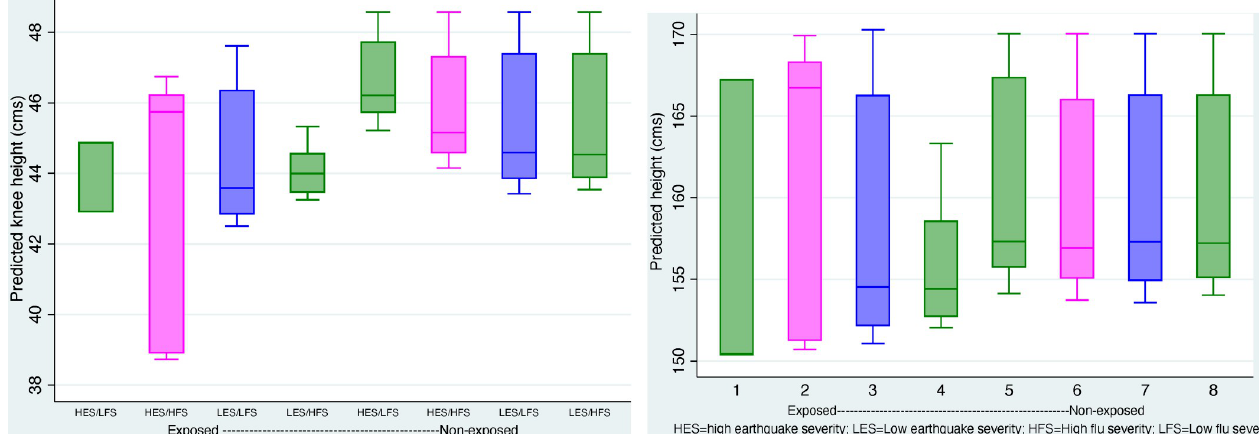
Fig 4. A. Box plots of predicted values of knee height. (Models including flu and earthquake-full sample). B. Box plots of predicted values of height. (Models including flu and earthquake-full sample).